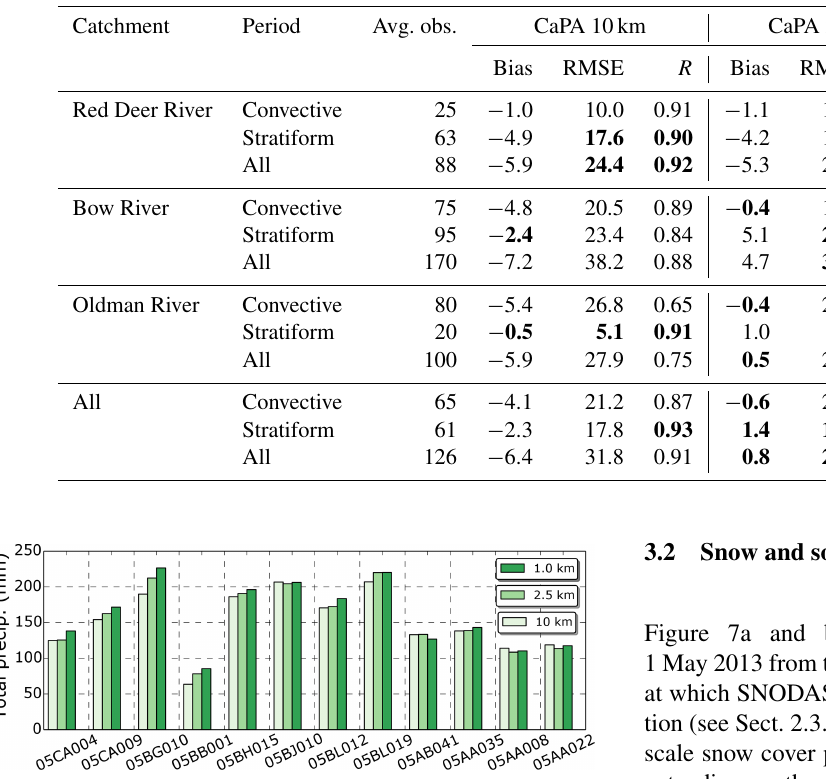
Figure 5. Accumulated precipitation from 19 June at 12:00UTC to 22 June at 12:00UTC averaged over the 12 basins shown in Fig. 2. for the CaPA experiments at different resolutions.